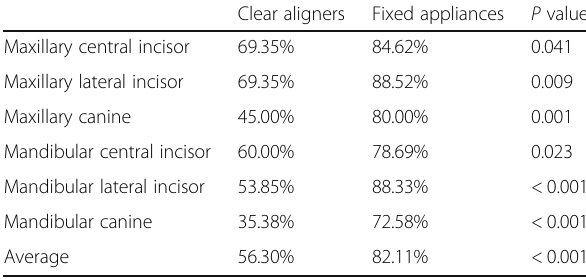
Table 3 Prevalence of apical root resorption in the two groups Clear